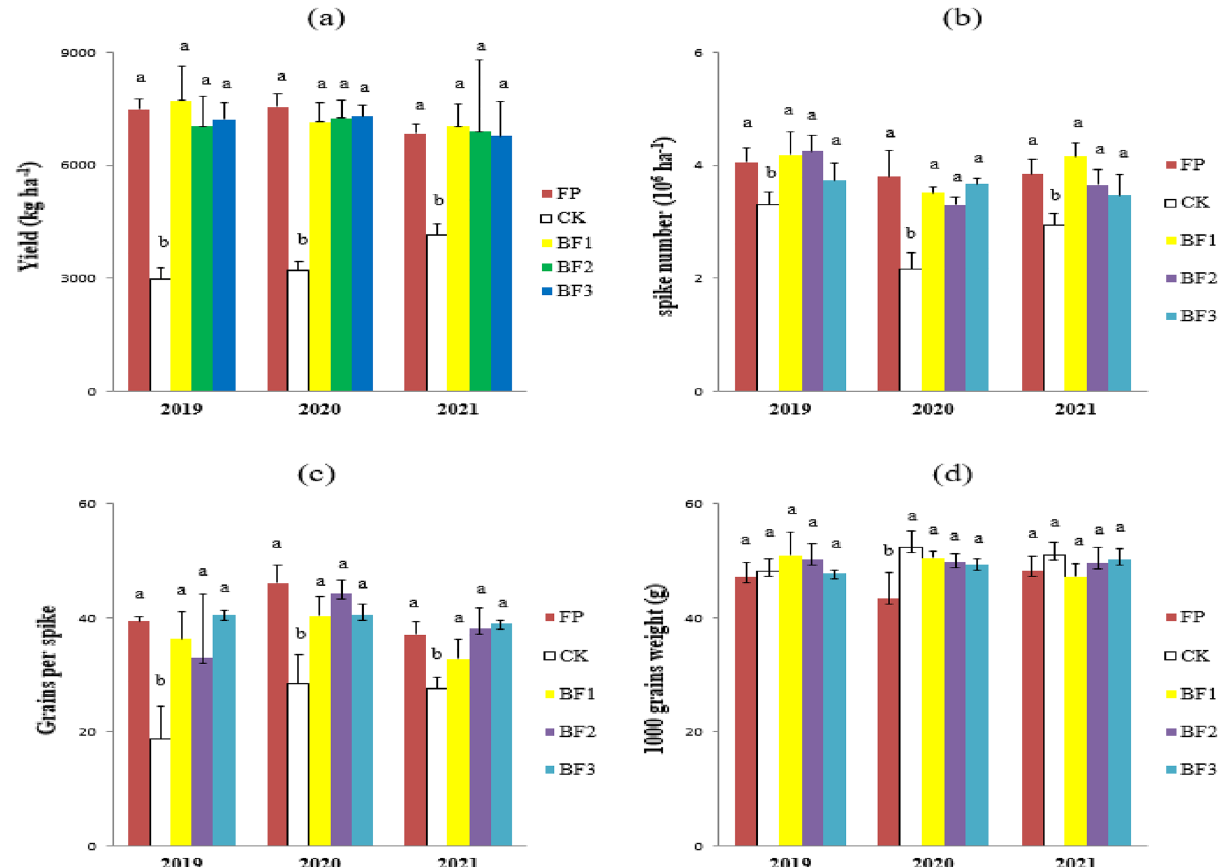
Figure 2. Effects of different balanced fertilization treatments on ( a ) yield, ( b ) spike number, ( c ) grains per spike and ( d ) 1000 grain weight of spring wheat from 2019 to 2021. The data are the means and standard errors of three independent measurements. Values within a separate year with the same letter are not significant at the P = 0.05 level. FP, CK and BF indicate farmer practice, control and balanced fertilization,